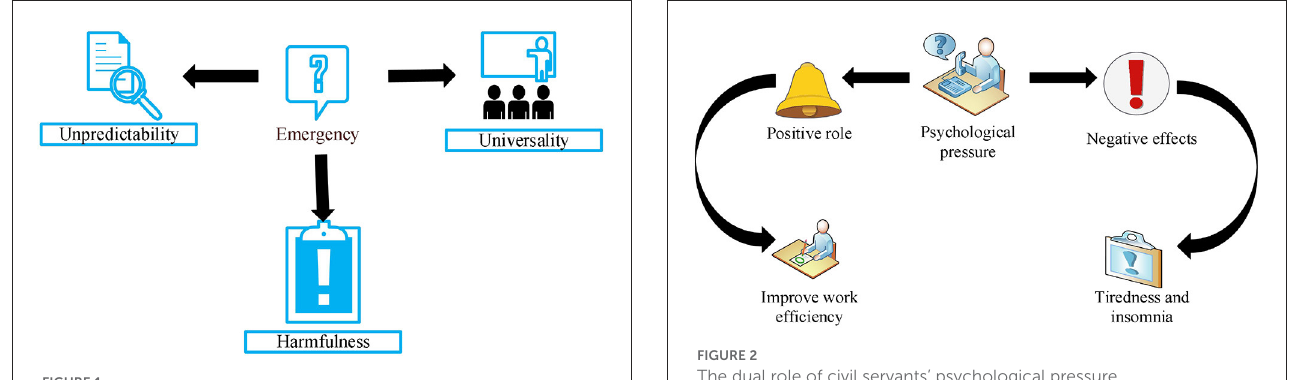
FIGURE1 Characteristics of public emergencies.